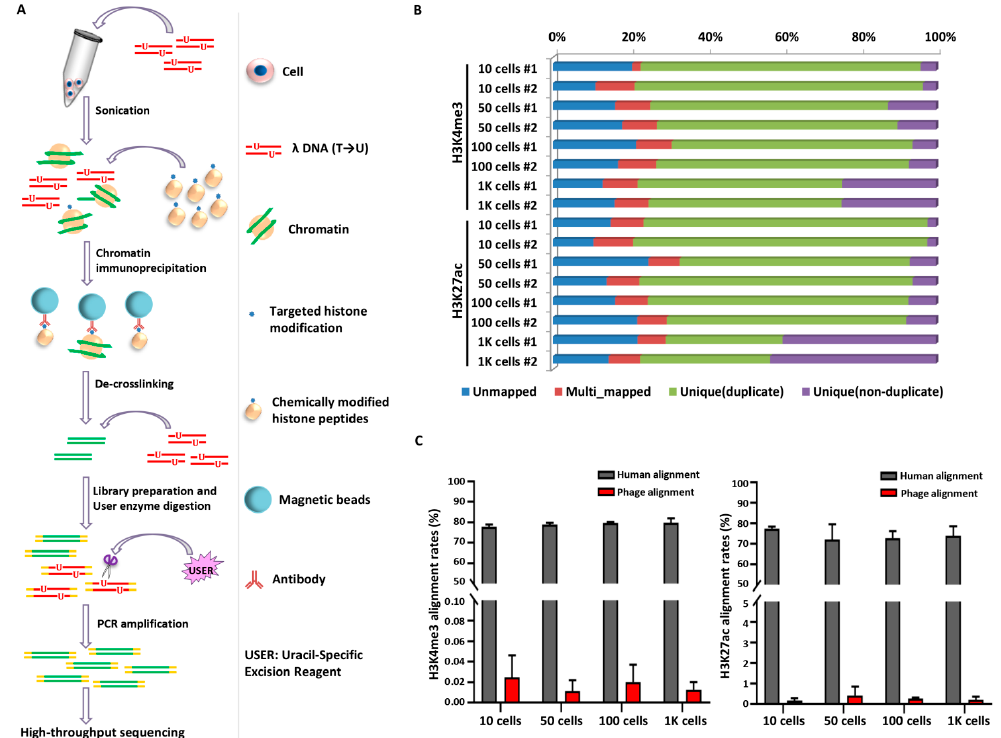
Figure 1. 2cChIP-seq strategy overview and data quality presentation. ( A ) The scheme illustrates the conceptual design and key steps of the 2cChIP-seq protocol. The dUTP-containing lambda DNA fragments and chemically modified histone peptides are added as carriers during ChIP DNA preparation and library generation. ( B ) Deep sequencing features of 2cChIP-seq reads. ( C ) The plot depicts the proportions of 2cChIP-seq reads aligned to the human or lambda reference genome. Data were obtained from two independent experiments. The labels (#1 and #2) represent two 2cChIP-seq replicates.